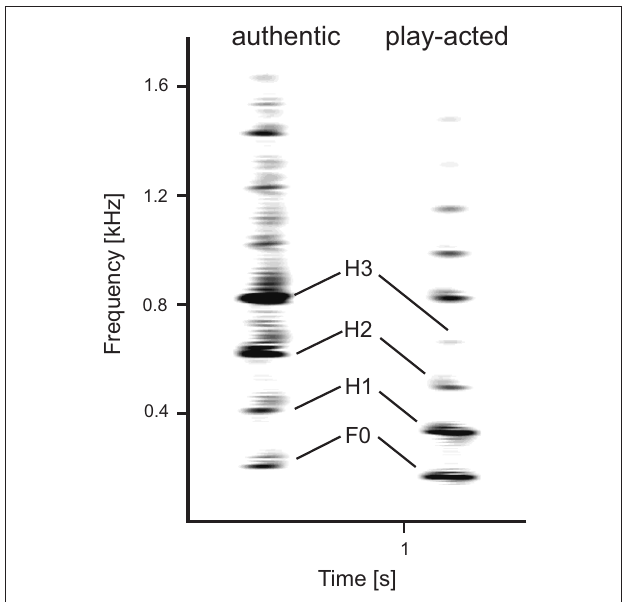
FIGURE 2 | Differences in the energy distribution of the lower frequency bands between authentic and play-acted utterances. The authentic stimulus possesses high amplitude ratios between the second harmonic and the F 0 (amprat 2 = 3) and between third and first harmonic (amprat 3 = 2.71), while the play-acted stimulus is characterized by lower values (amprat 2 = 0.28, amprat 3 = 0.3). The differences in the F positions are due to individual differences. 0 Given are the FFT spectrograms of one authentic and one play-acted female spoken “a” with a sampling rate of 2.7 kHz (Avisoft-SASLabPro).